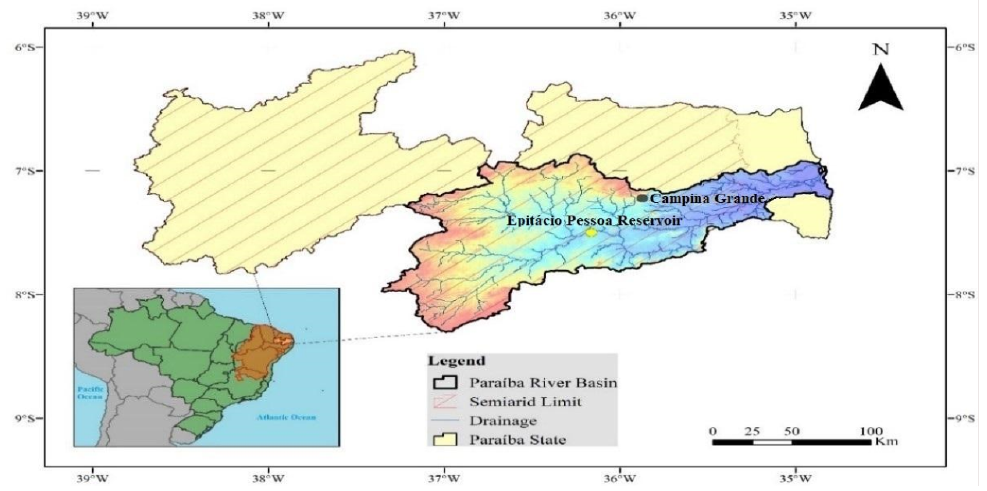
Figure 1. Epit á cio Pessoa Reservoir in the Para í ba River basin in Northeast Brazil.